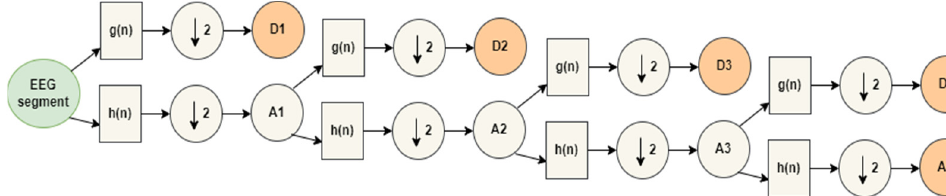
Figure 4. An example of a four-level decomposition of DWT. Table 1. Frequency sub-bands for each wavelet coefficient. Wavelet Coefficient and Its Frequency